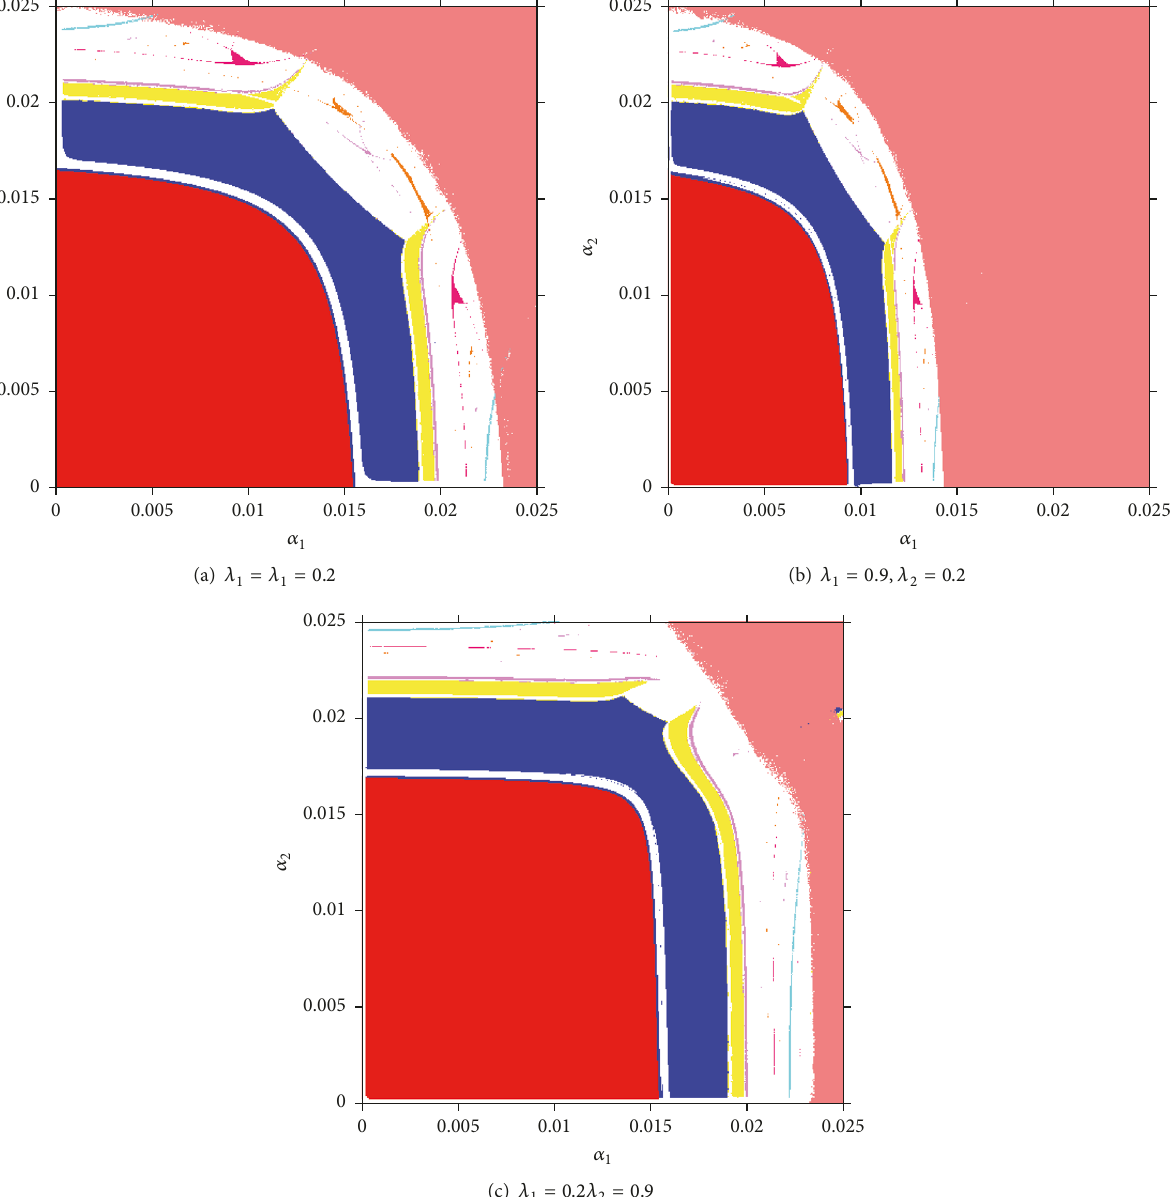
Figure2:2Dparameterbifurcationinthe( 𝛼 1 , 𝛼 2 )plane(red(stable),blue(2-period),lightblue(3-period),yellow(4-period),pink(5-period), orange (7-period), purple (8-period), white (chaos), and coral